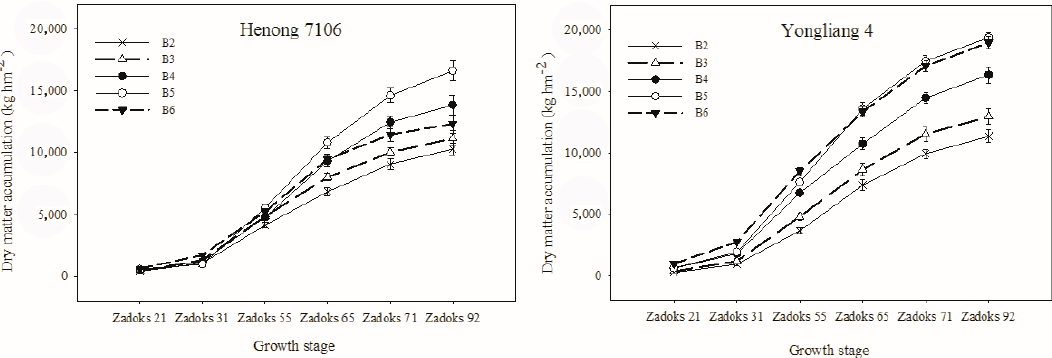
Figure 3. The differences in dry matter accumulation (DMA) of wheat sown on different dates (2015– 2016).